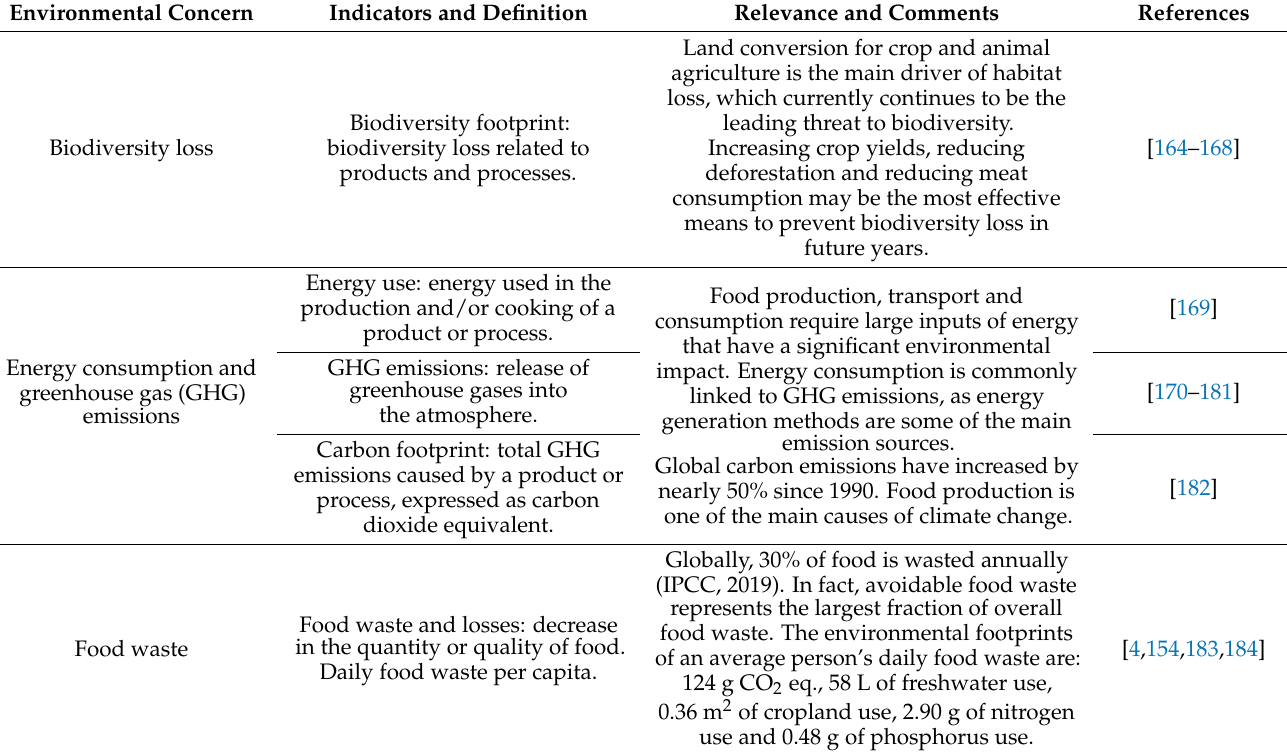
Table 3. Indicators of an environmentally sustainable diet